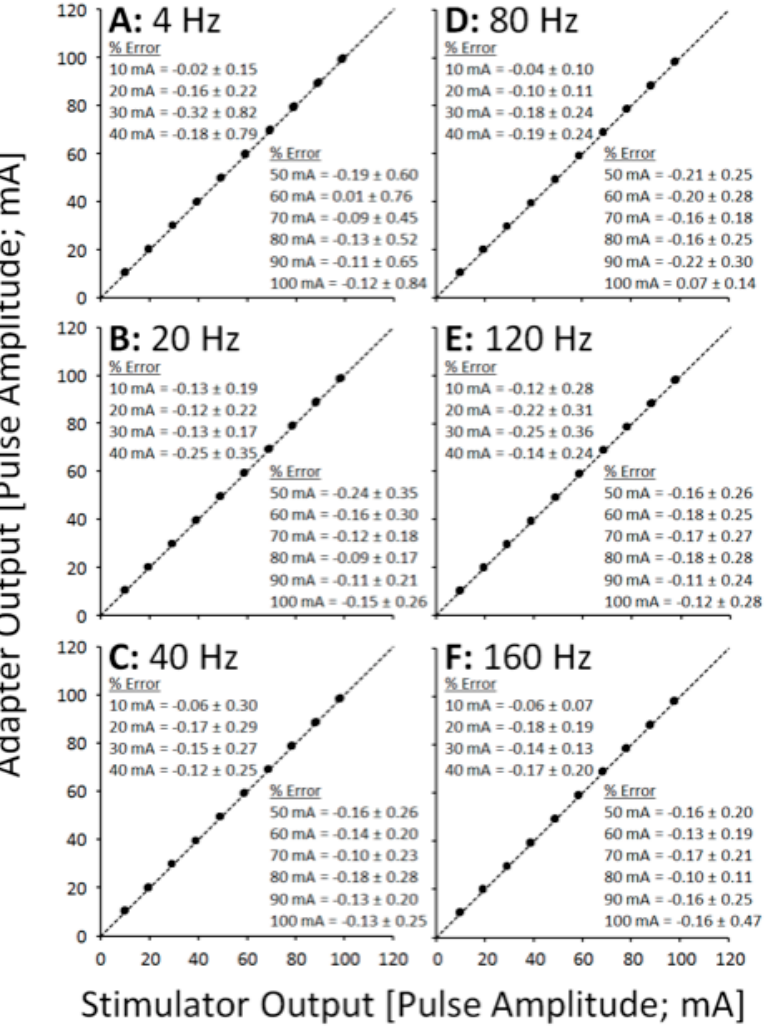
Figure 3. Scatter plots showing adapter pulse amplitude outputs vs. stimulator pulse amplitude outputs across frequencies ( A – F ).